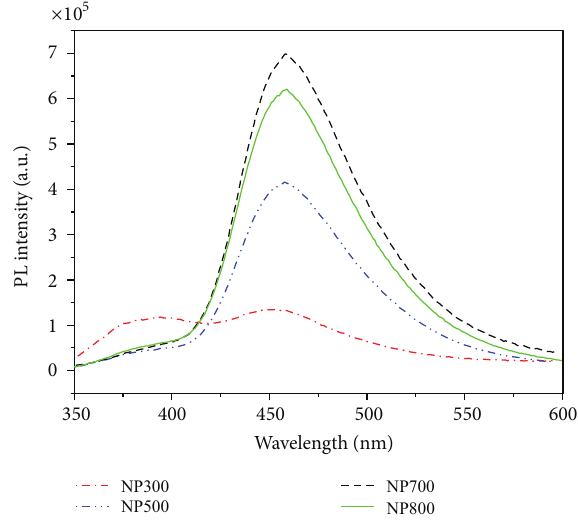
Figure 6: Photoluminescence spectra of coumarin solution (10 −3 molL −1 , pH 3.3) after 120min of UV-A irradiation in the presence of N-TiO 2 powders annealed at different